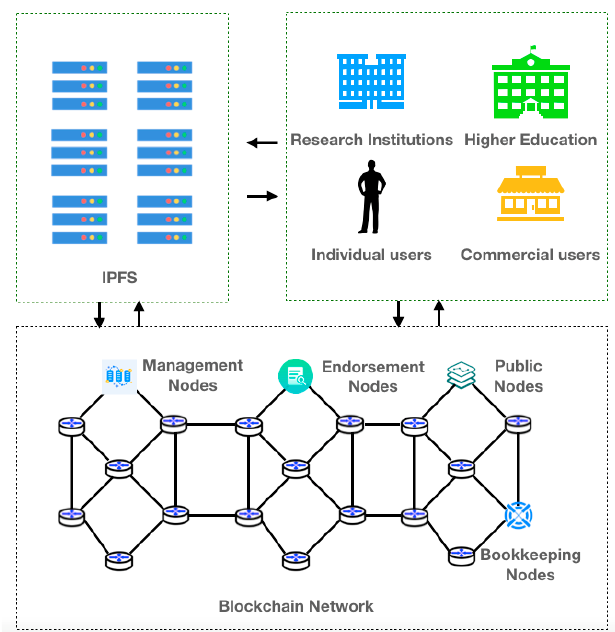
Figure 2. Blockchain- and IPFS-based data storage model for birds. Table 1. Bird data storage pattern based on blockchain and IPFS characteristics table.